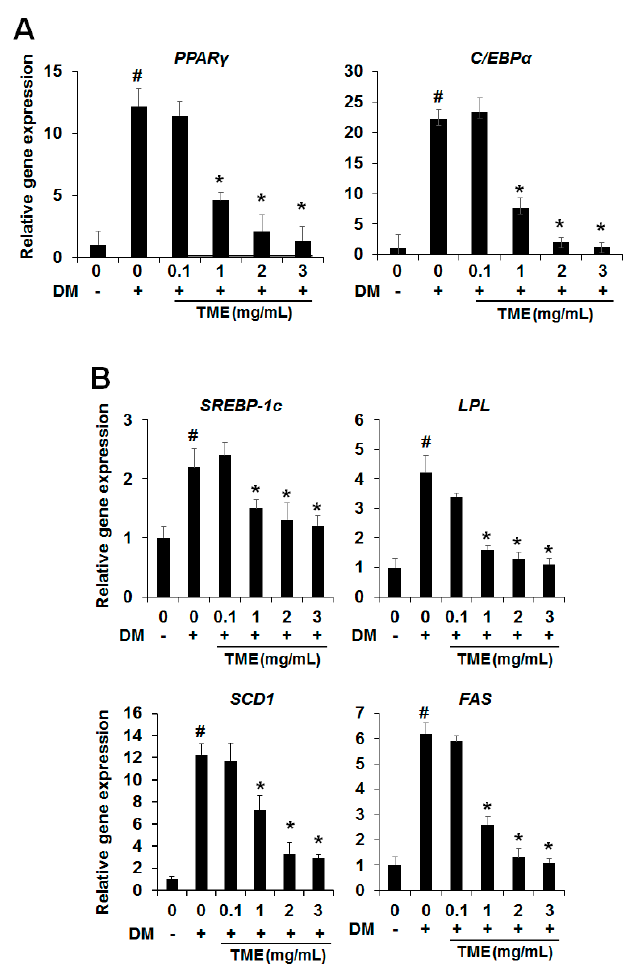
Figure 2. Effect of TME on gene expression of key adipogenic transcription factor- and adipocyte-specific markers. Cells were induced to differentiate into adipocytes in differentiation medium (DM) with or without TME and messenger RNA (mRNA) expression levels of adipogenic transcription factors ( A ); and adipocyte-specific markers ( B ) were measured using real-time polymerase chain reaction (PCR), respectively. Results are presented as mean ± SD of triplicate. # p -value of <0.05 indicates significant difference from non-differentiated control. * p -value of <0.05 indicates significant difference from differentiated control without TME. PPAR γ : peroxisome proliferator-activated receptor gamma; C/EBP α : CCAAT/enhancer binding protein; SREBP-1c : sterol regulatory element binding transcription factor 1c; LPL : lipoprotein lipase; SCD 1 : stearoyl-CoA desaturase-1; FAS : fatty acid synthase.